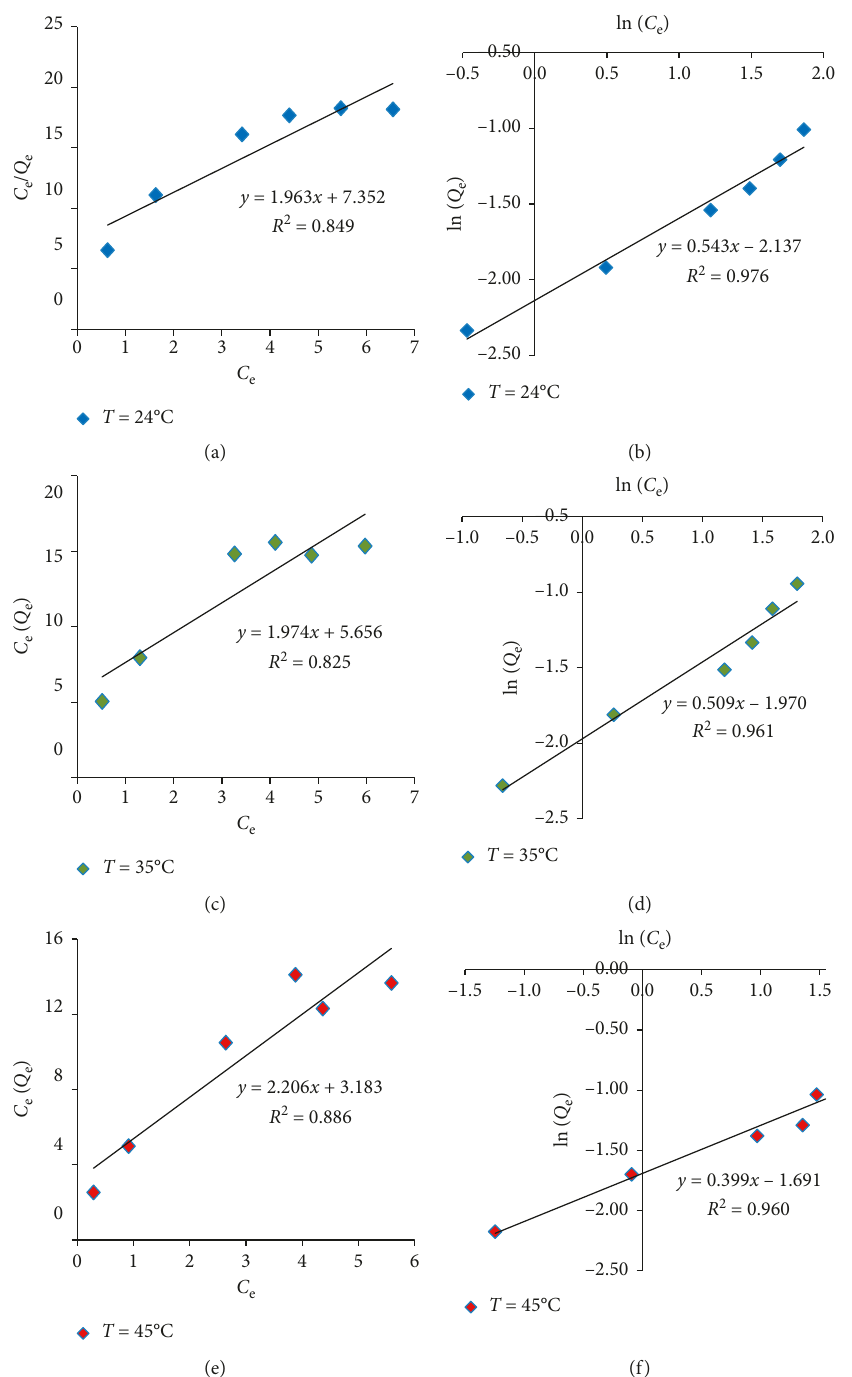
Figure 9: Linearization of the Langmuir (a, c, e) and Freundlich (b, d, f) equations for the phosphorus adsorption on Oued Boufekrane